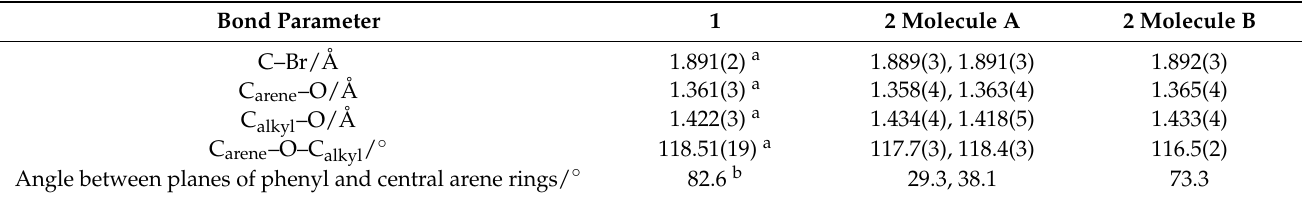
Table 1. Selected bond lengths and angles in compounds 1 (polymorph I, for the molecule containing Br1) and compound 2 (both independent molecules A (with Br1 and Br2) and B (with